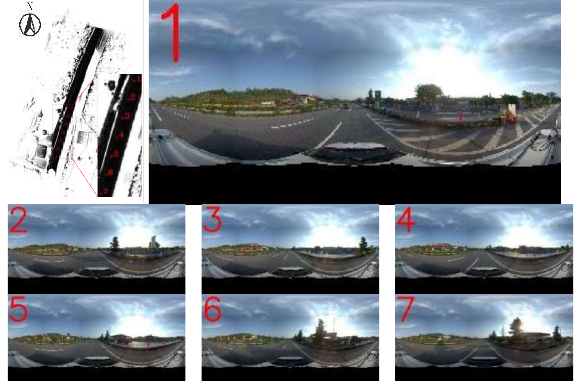
Figure 3 . Dataset , plane map of the MMS LiDAR points (2449×1600, 320 m ×490 m ) and the panoramic image sequence, the red dots and number express 7 panoramic images